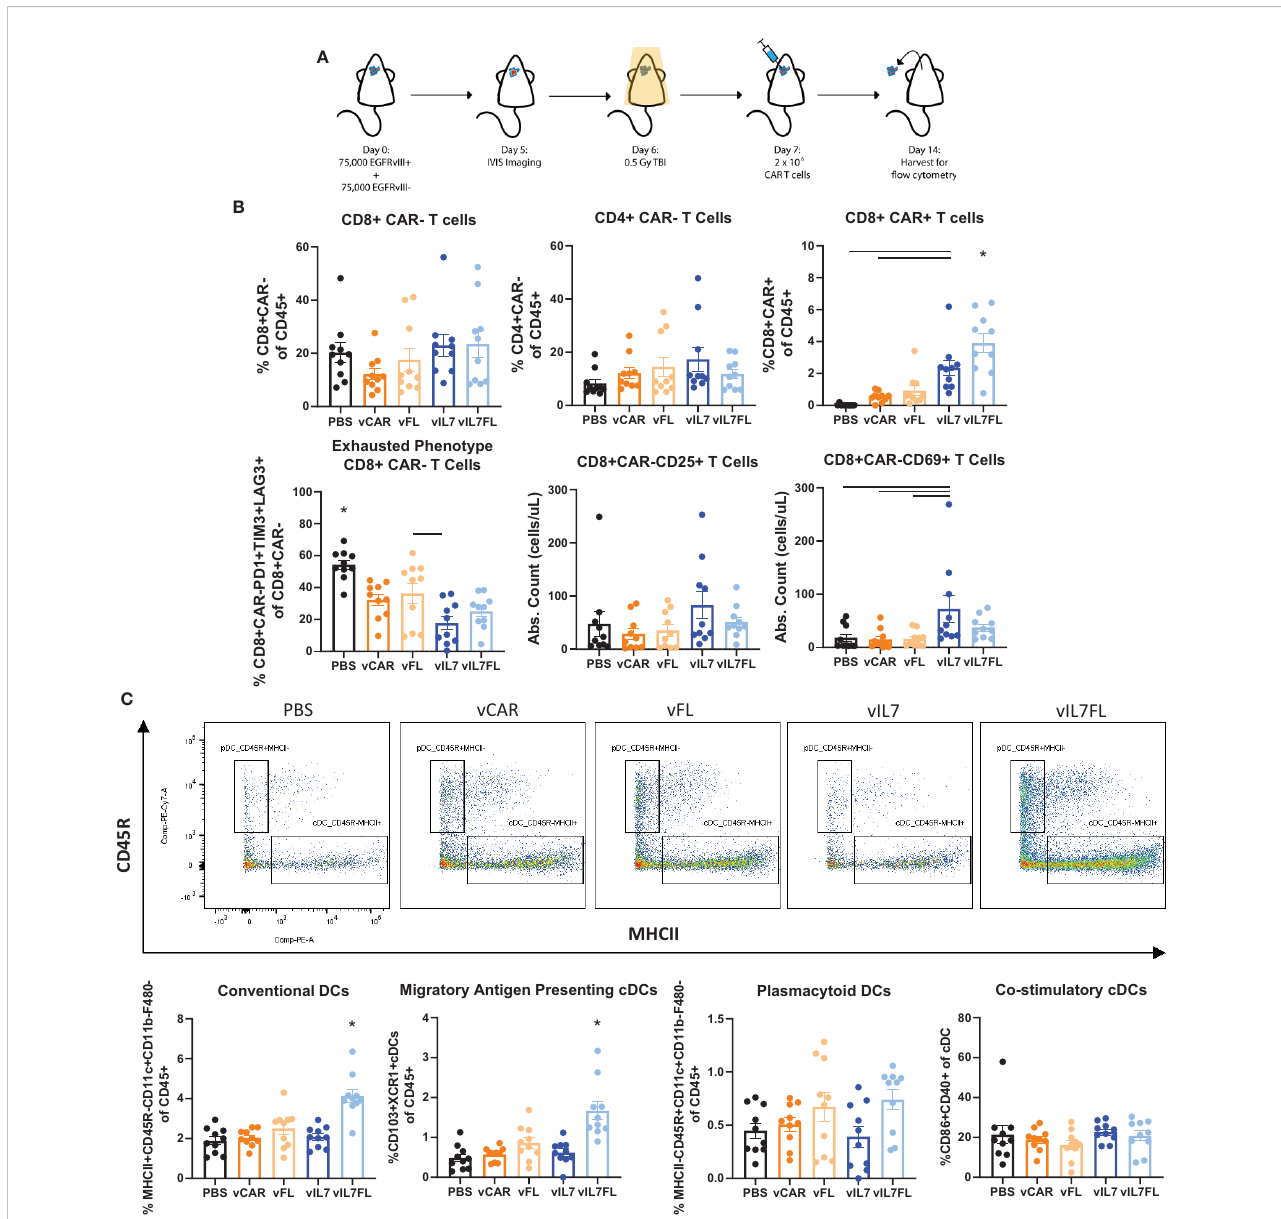
FIGURE 3 IL7 and IL7 Flt3L co-expressing CAR T cells increased CD8 CAR T cells and IL7 co-expression with Flt3L enhanced intratumoral DCs. (A) Schematic of experiment. Animals were inoculated with 50% vIII and 2A tumors and IVIS imaged 5 days later. On day 6, 0.5 Gy TBI was applied and 2x10^6 CAR T cells were injected intracranially the following day. (B) Flow cytometry was performed on the tumor-bearing hemisphere isolated on day 14 and split into two panels with the analysis of the T cell panel shown. (C) Analysis of DC populations using fl ow cytometry. Data represents a combination of